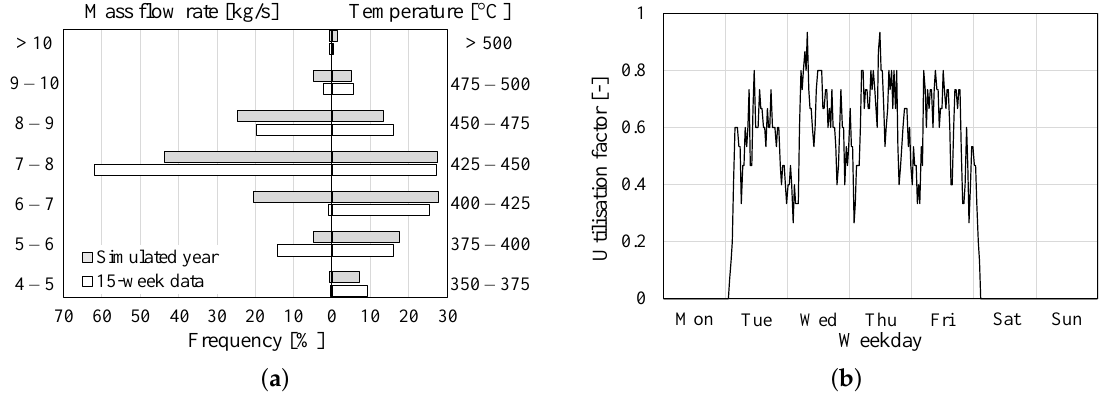
Figure 4. Waste heat. ( a ) temperature and mass flow frequency distribution; ( b ) utilisation factor based on 15-week